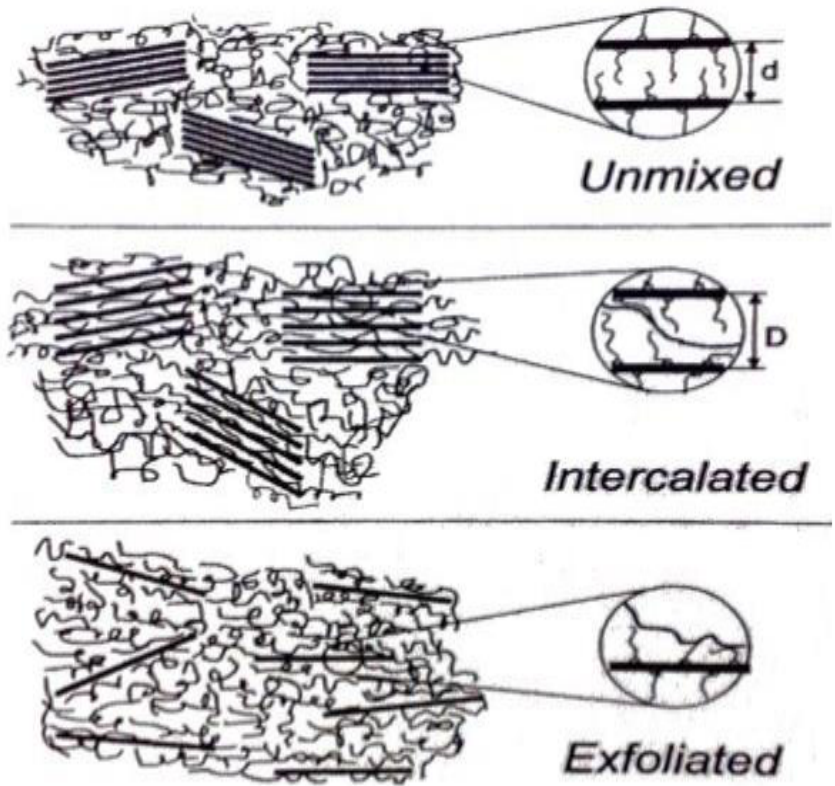
Fig. 4. Distribution of nanoparticles in the polymer